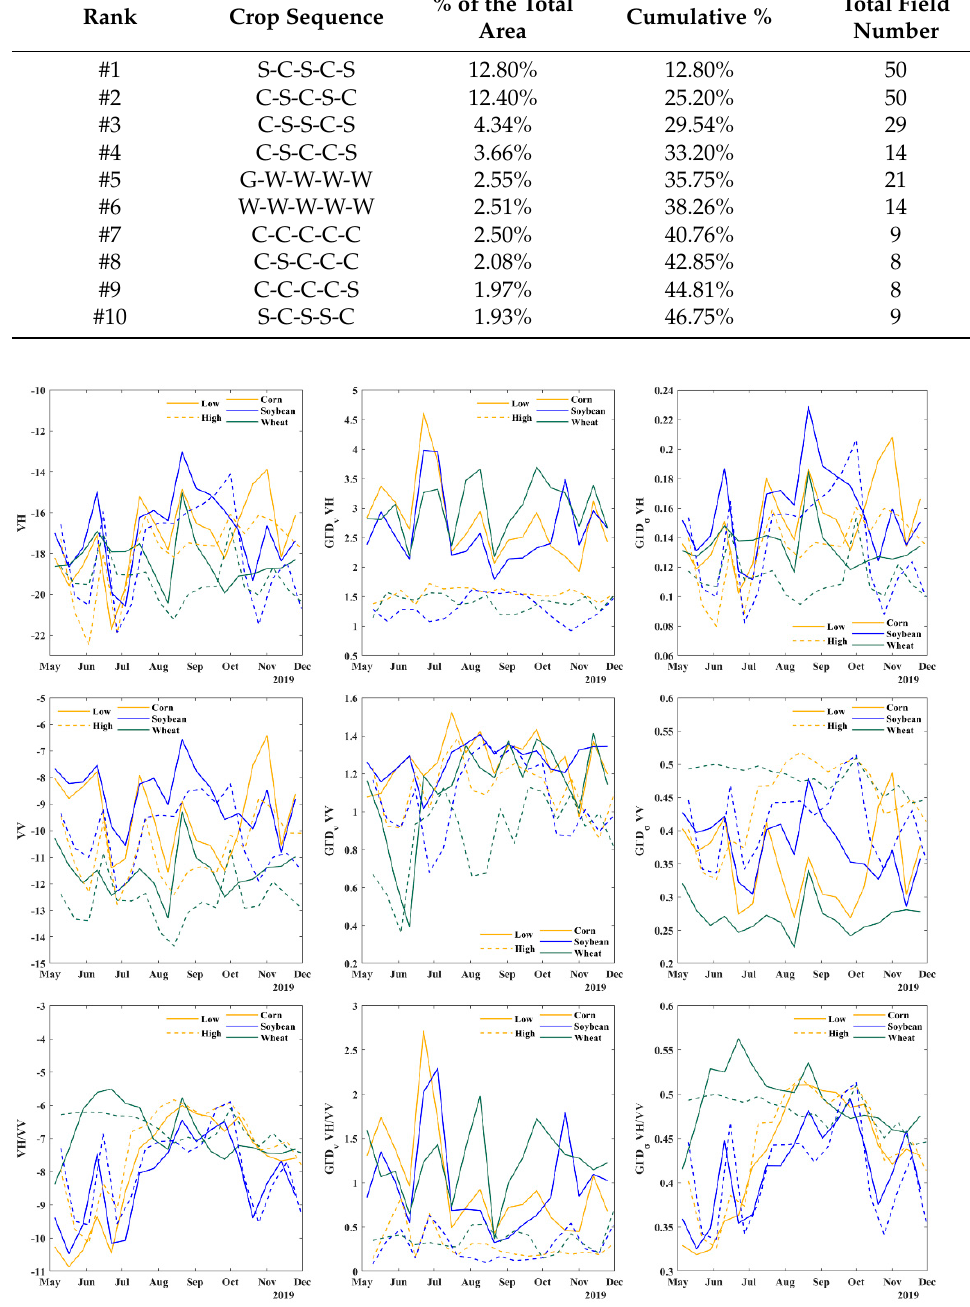
Table 4. The ten major crop sequences of the study area (in terms of total field areas) from 2017 to 2021. S = soybean, C= corn, W = wheat, and G = grass.